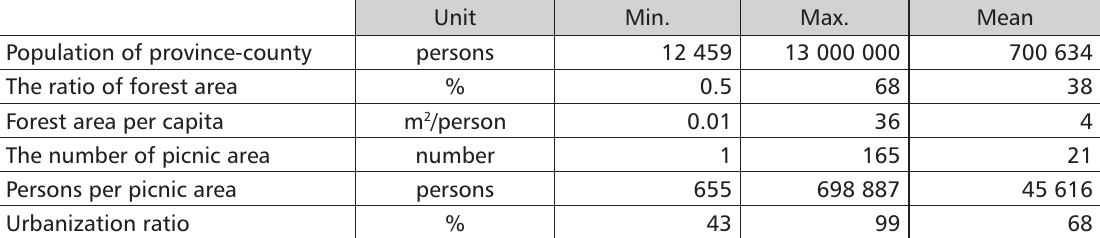
Characteristics for provinces/counties including urban forests